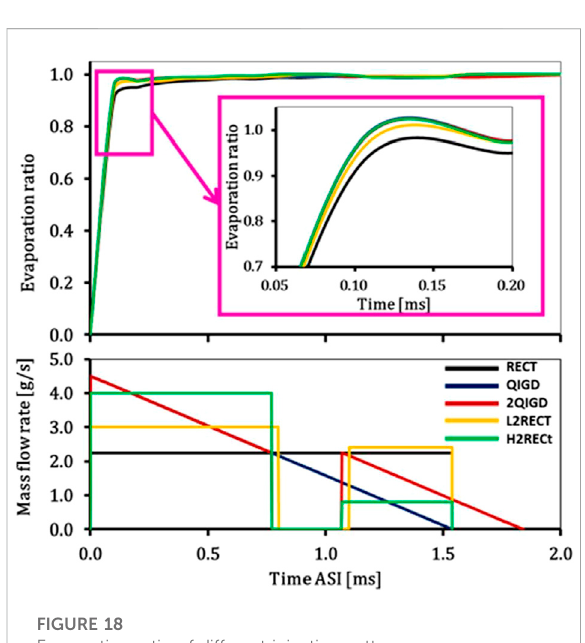
FIGURE 18 Evaporation ratio of different injection